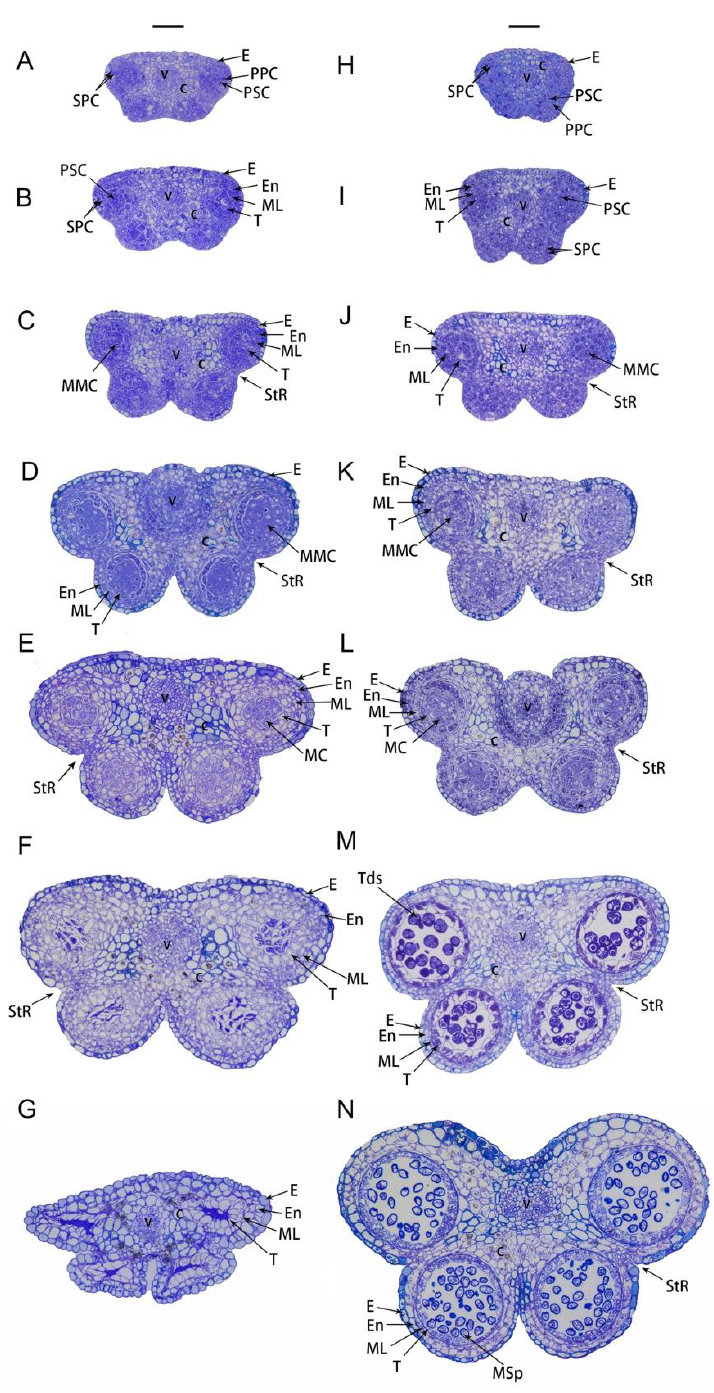
Figure 2. Cytological observation of anthers in female ( A – G ) and male ( H – N ) flowers by develop- mental. stage. ( A , H ) stage 3; ( B , I ) stage 4; ( C , J ) stage 5; ( D , K ) stages 5–6; ( E , L ) stage 6; ( F , M ) stage 7; ( G , N ) stages 8–9. Bars indicate 40 μm for all the stages. E, epidermis; En, endothecium; SPC, secondary parietal cell; PPC, primary parietal cell; PSC, primary sporogenous cell; En, endothecium; ML, middle layer; T, tapetum; StR, stomium region; MMC, microspore mother cells; MC, meiotic cell; Tds, tetrads; MSp, microspores; V, vascular region; C, connective.